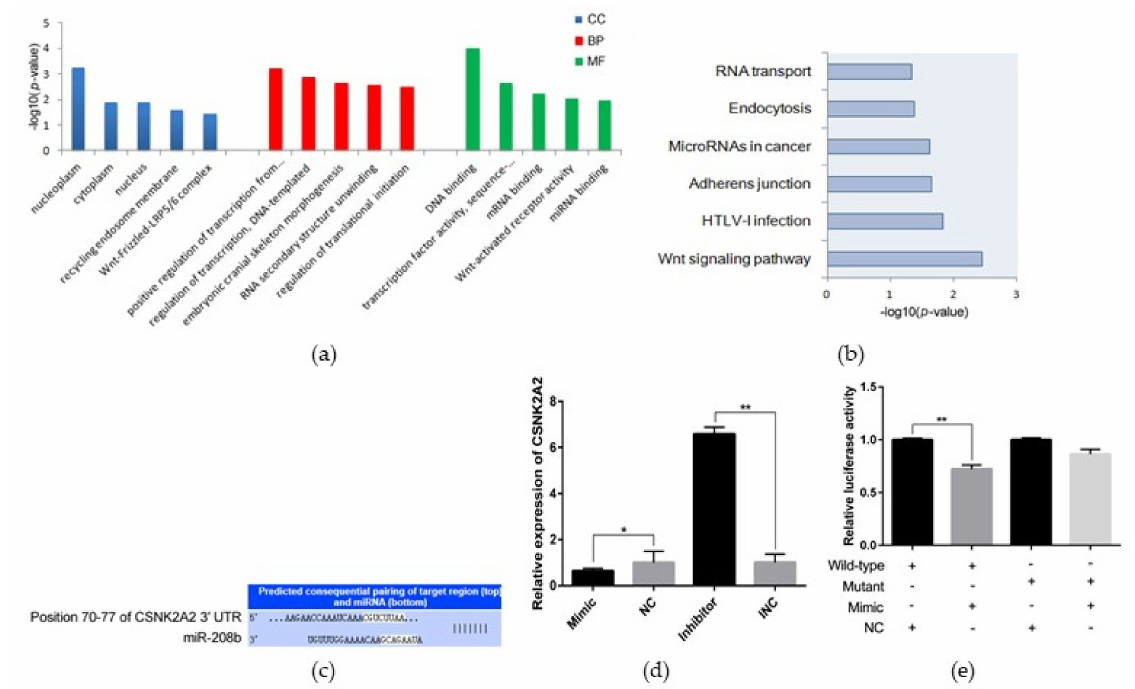
Figure 4. CSNK2A2 is one of the target genes of miR-208b. ( a ) GO analysis of miR-208b target genes, only showing the top 5 significantly GO terms in BP, CC, and MF ( p < 0.05). ( b ) The significantly enriched pathway of miR-208b target genes by using the KEGG database ( p < 0.05). ( c ) The predicted binding site of gene CSNK2A2 with miR-208b. ( d ) CSNK2A2 mRNA levels after transfecting with the miR-208b mimic, NC, INC, and miR-208b inhibitor 24 h. ( e ) Luciferase assays were performed by cotransfection of wild-type or mutant plasmids with a miR-208b mimic in Hela cell, and the NC group was used as the control group ( n = 3). The data are presented as means ± SEM ( n = 9). * p < 0.05; ** p <